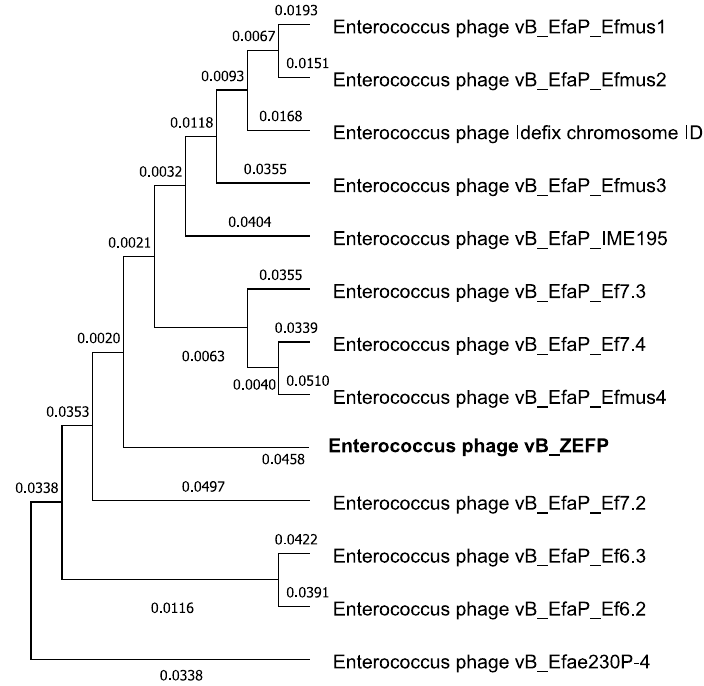
Figure 6. Phylogenetic relationships between Picovirinae phages that infect Enterococcus. Table 2. Phage vB_ZEFP ORFs with putative protein encoding functions.